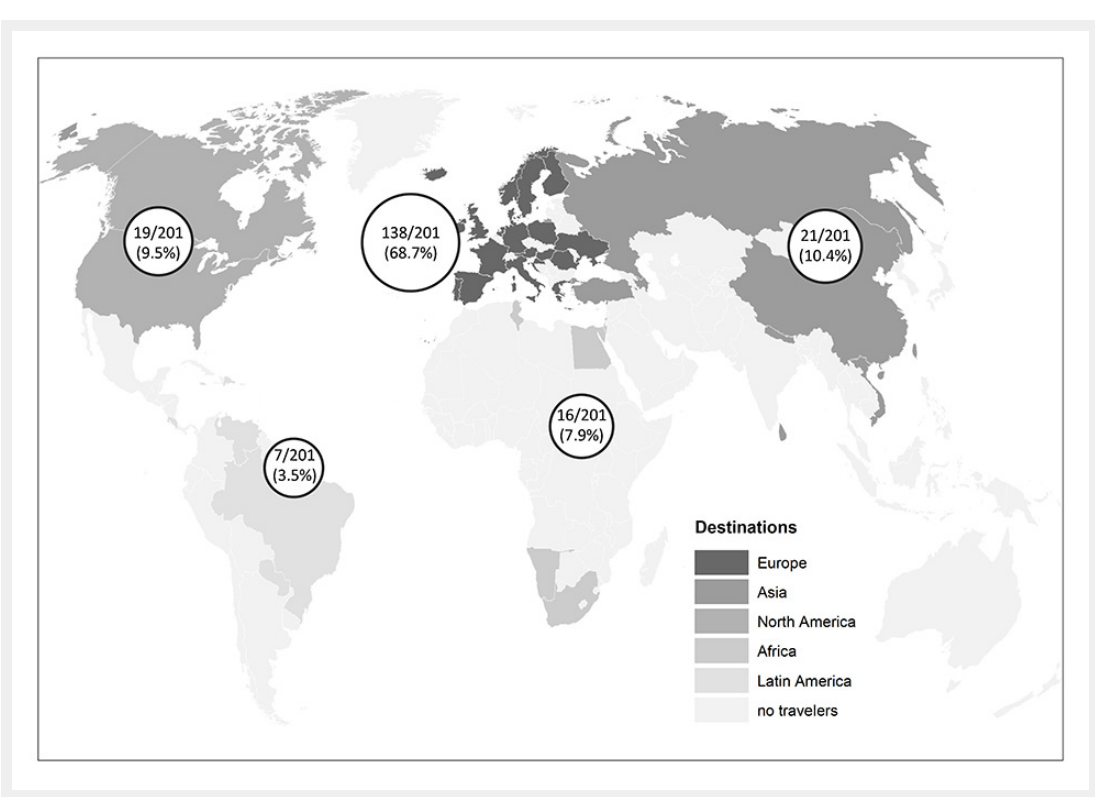
Figure 1 Distribution of reported travel destinations. In total 201 travel episodes were